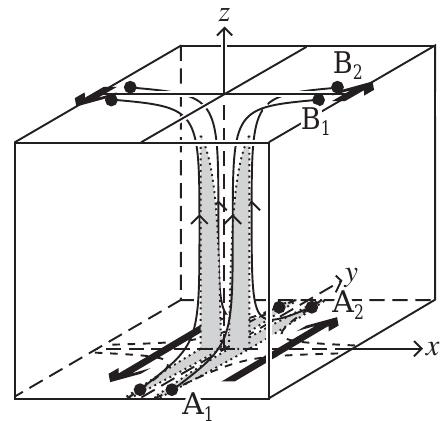
Figure 8. The magnetic structure near a quasi-separator located along the z